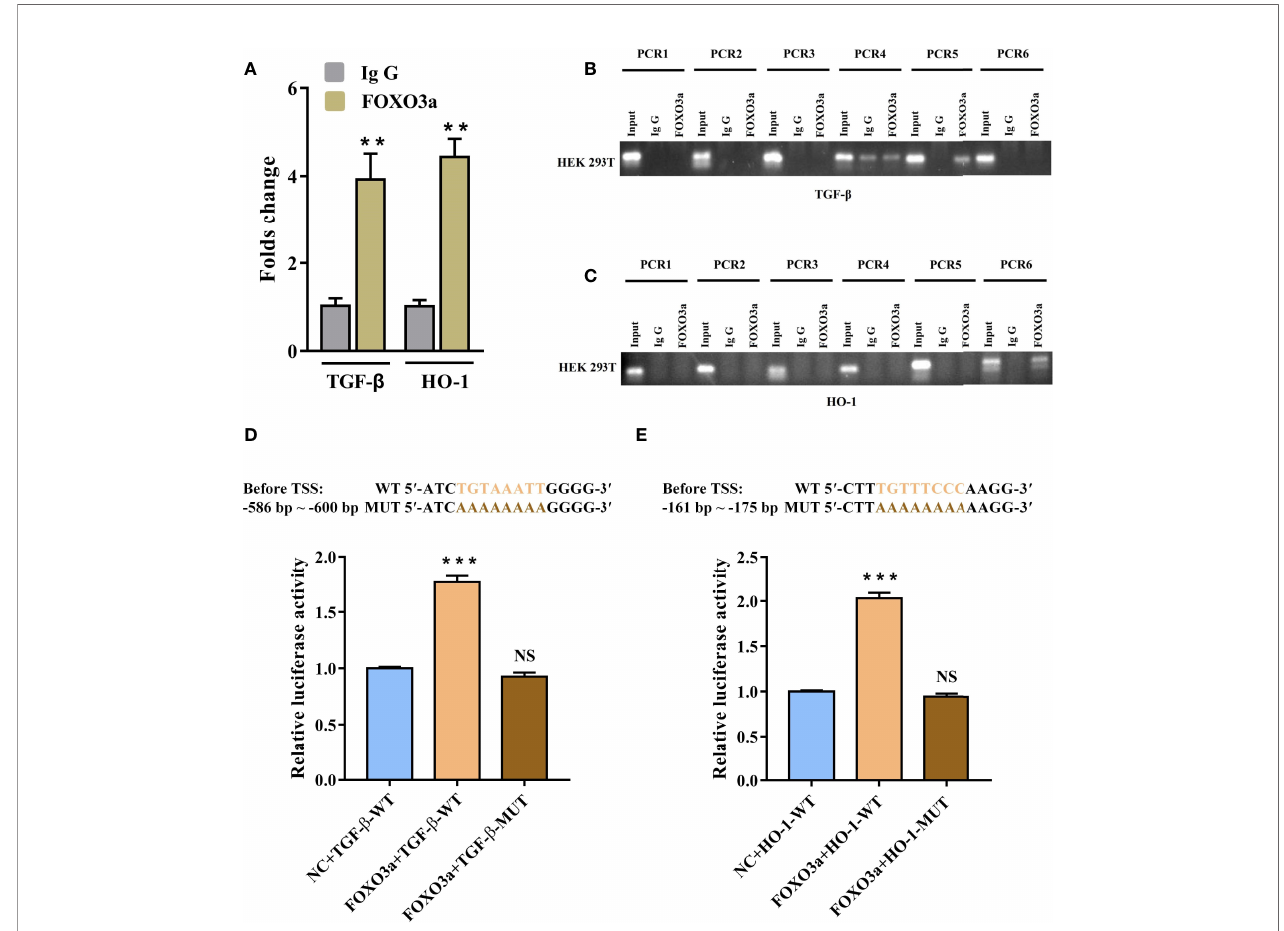
FIGURE 6 | FOXO3a directly binds to TGF- b and HO-1 gene promoter. (A – C) Assessment of FOXO3a binding to TGF- b and HO-1 sequence in HEK-293 T cells was performed by ChIP-PCR. The fold change values were normalized to the negative control IgG. (D – E) Wild-type and mutant vectors of TGF- b (D) and HO-1 (E) based on the two positive binding sites in ChIP were synthetized. The luciferase activities of the constructs of TGF- b and HO-1 sequence in HEK-293 T cells transfected with either FOXO3a expression plasmid or controls. All data were expressed as mean ± SEM of three independent experiments (n = 3). The differences between experimental group and NC group were analyzed using Student ’ s t-test. ** P < 0.01, *** P < 0.001; NS, not signi fi cant versus NC group. TGF- b -WT, wild- type vectors of TGF- b ; TGF- b -MUT, mutant vectors of TGF- b ; HO-1-WT, wild-type vectors of HO-1; HO-1-MUT, mutant vectors of HO-1; NC, negative